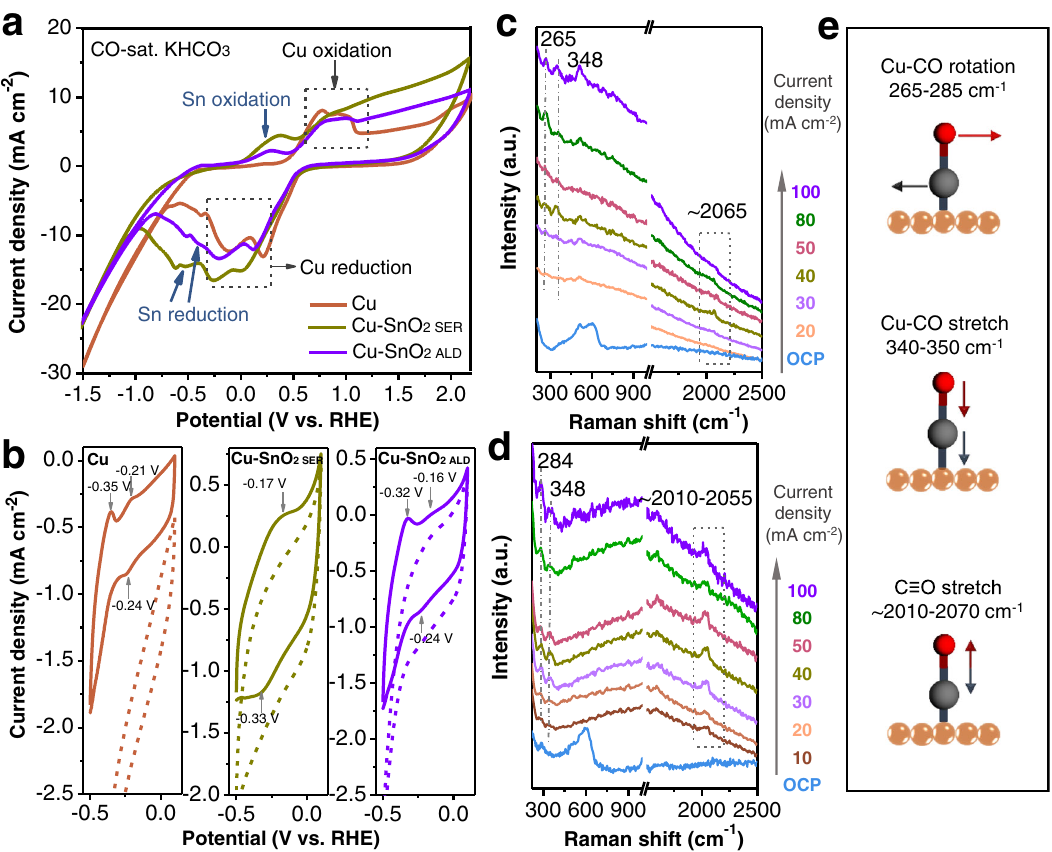
Fig. 4 | CO adsorption feature and in situ Raman measurement on Cu and Cu- SnO 2 catalysts. a Cyclic voltammograms of Cu, Cu-SnO 2 SER and Cu-SnO 2 ALD cat- alystsmeasuredina fl owcellwith0.5MKHCO 3 (pH=8.36)andCObeing fl owedat 0.375 and 50cm 3 min − 1 , respectively, at a scan rate of 50mVs – 1 . b Cyclic voltam- mograms of Cu, Cu-SnO 2 SER and Cu-SnO 2 ALD catalysts measured within a narrow